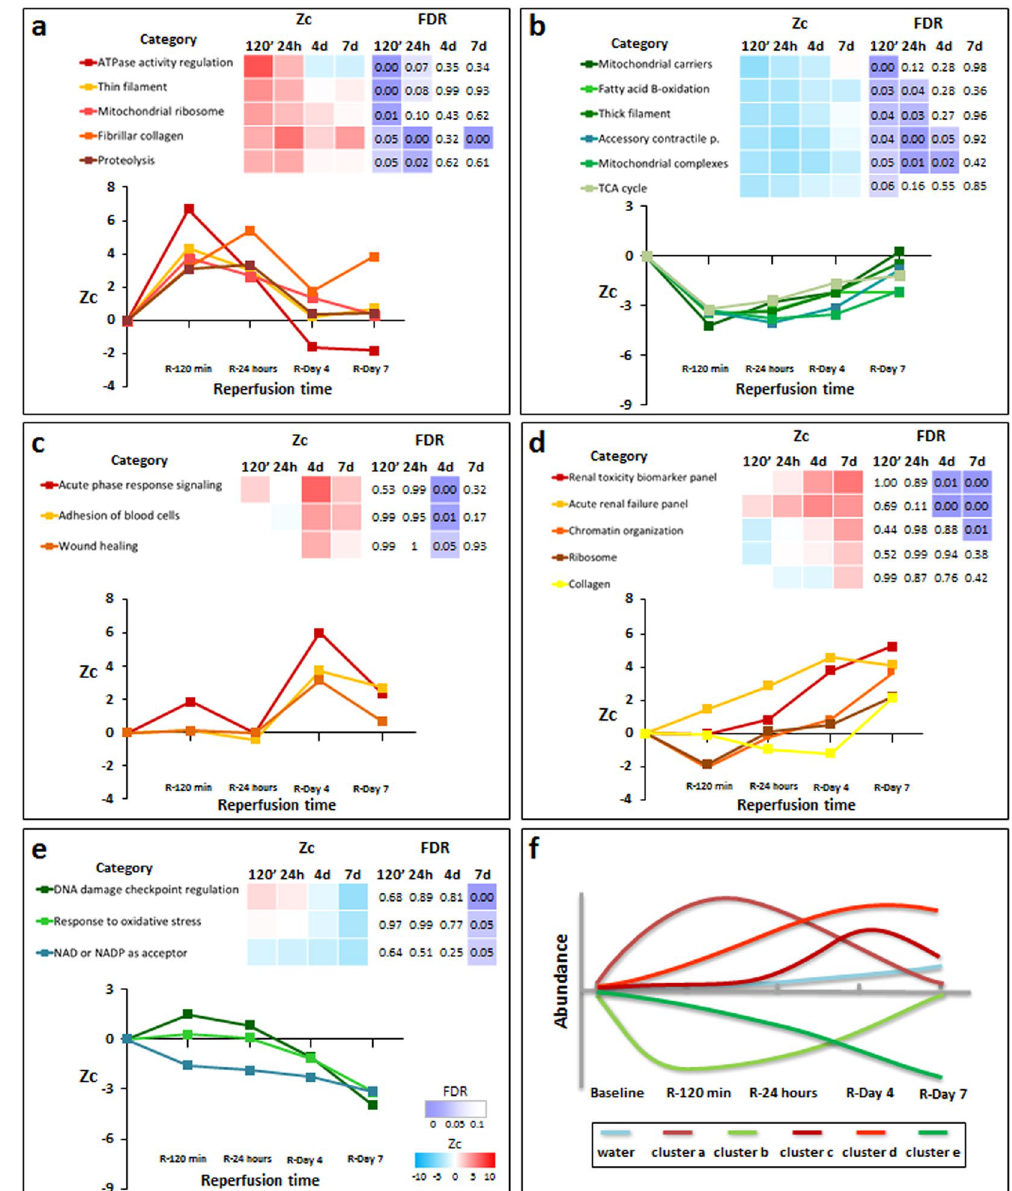
Figure 5. Quantitative proteomics time course analysis of early reperfusion after acute infarction in the remote myocardium. Quantitative proteomics screening approach results are presented as in Fig. 3. Significantly altered functional categories were classified into five clusters ( a – e ): Cluster a, showing a transient increase at 120 min or 24 h; Cluster b, decreasing at 120 min and 24 h and reverting to almost normal values at day 7; Cluster c, reaching maximum upregulation at day 4, Cluster d, increasing gradually over time (this cluster included ribosome and collagen categories for comparison of results with the infarcted area); and Cluster e, decreasing in the late phase of reperfusion, reaching minimal values at day 7. Panel (f) shows a schematic chart of changes in water content and protein clusters. The complete set of proteins changing in each category is listed in Supplementary Tables S5–S9. The proteomics results presented here are representative of three technical replicate experiments using five animal sample